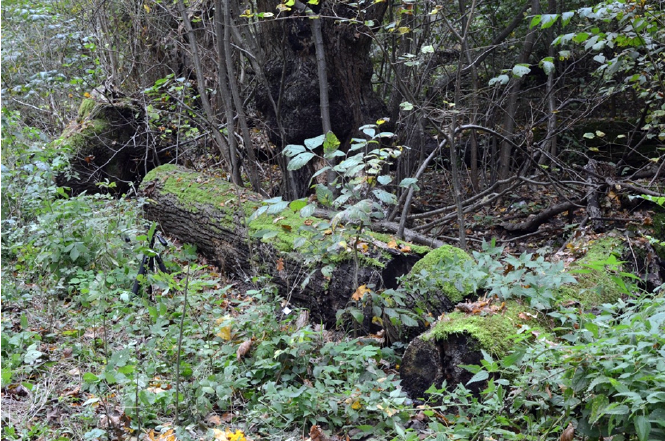
Figure 7 Coarse woodt debris in the Poznań-Radojewo park. Photo by B.